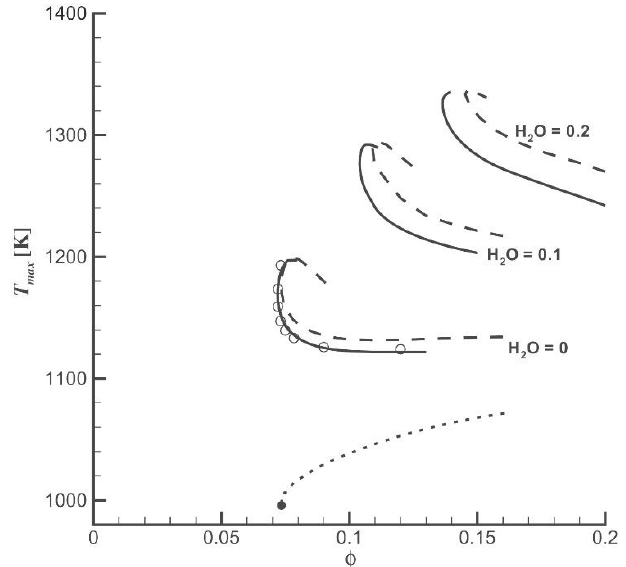
Figure 14. The variation with the equivalence ratio of the peak flame temperature as obtained from numerical integrations with the statistical narrow band (SNB) radiation model and 21-step chemical scheme (solid curve), with the SNB radiation model and the one-step reduced mechanism (circles), and with the optically thin approximation and the one-step reduced mechanism (dashed curve) [23].